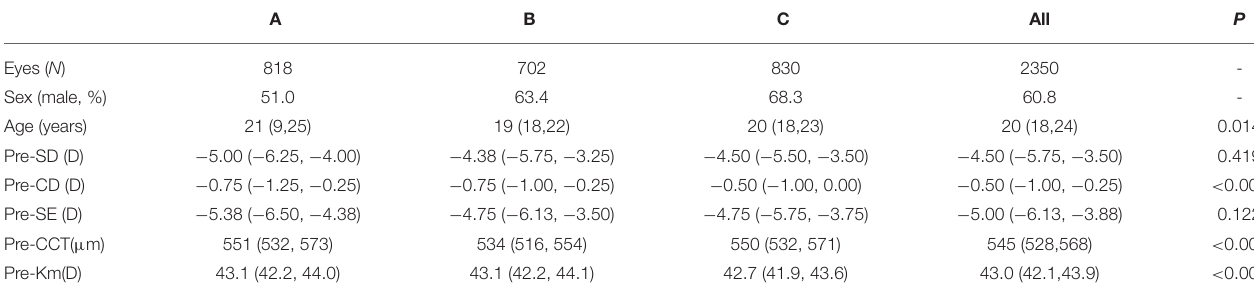
TABLE 1 | Baseline information in the three ophthalmic centers.